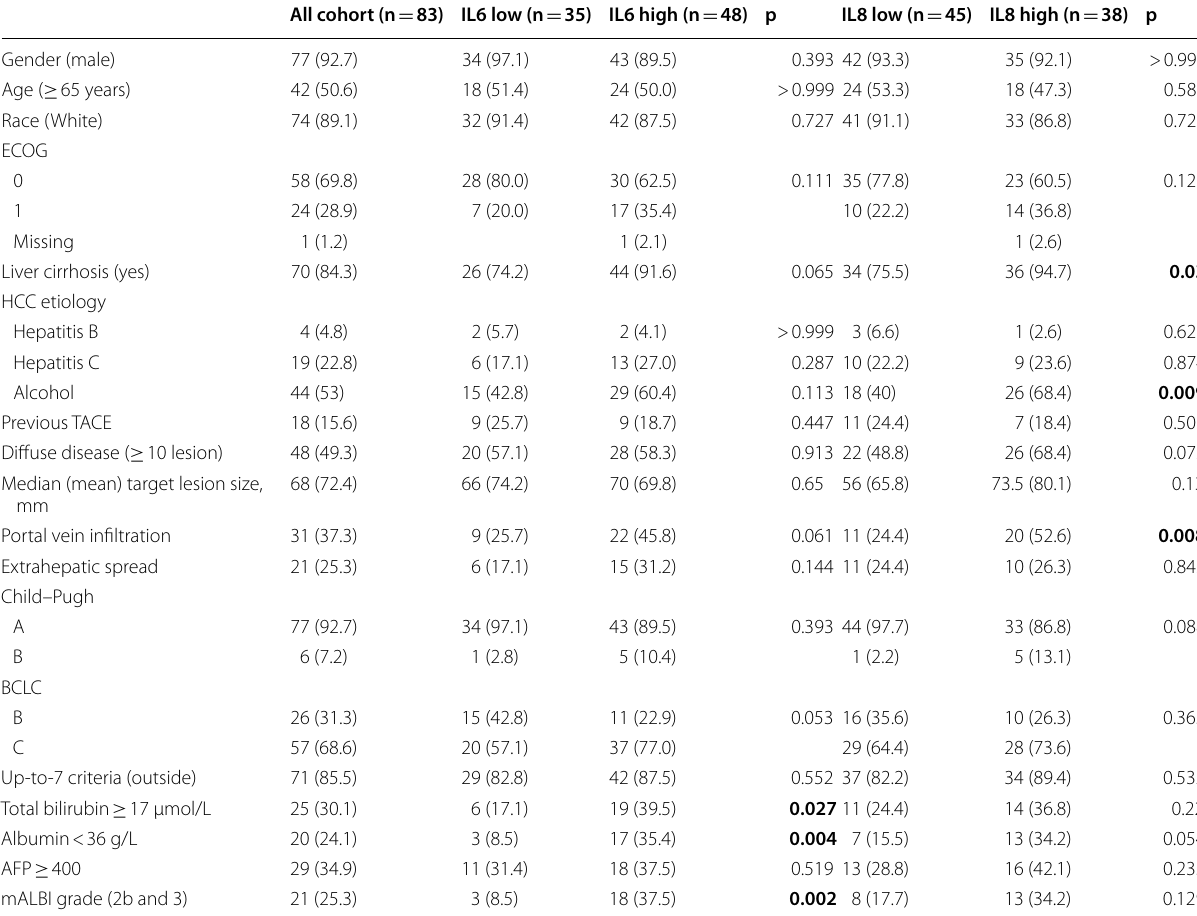
Table 1 Patient demographics and comparison of baseline characteristics of